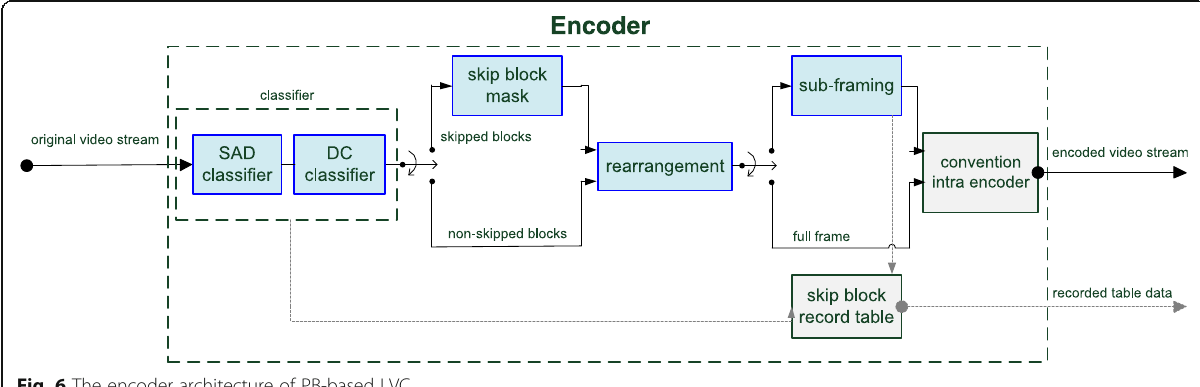
Fig. 6 The encoder architecture of PB-based LVC